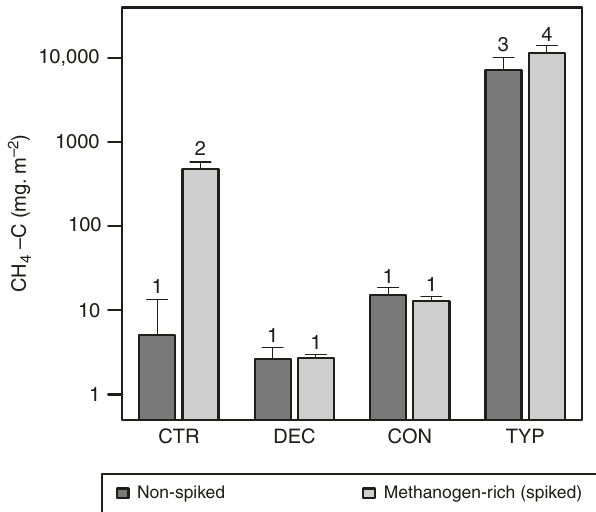
Fig. 1 CH 4 production in amended sediments. Production over a 150-day growing season is orders of magnitude higher in sediments amended with 20% organic matter from emergent macrophyte ( Typha latifolia ; TYP) litter than deciduous (DEC) or coniferous (CON) forest litter. CH 4 production increases further with addition of methanogen-rich sediment (i.e.,